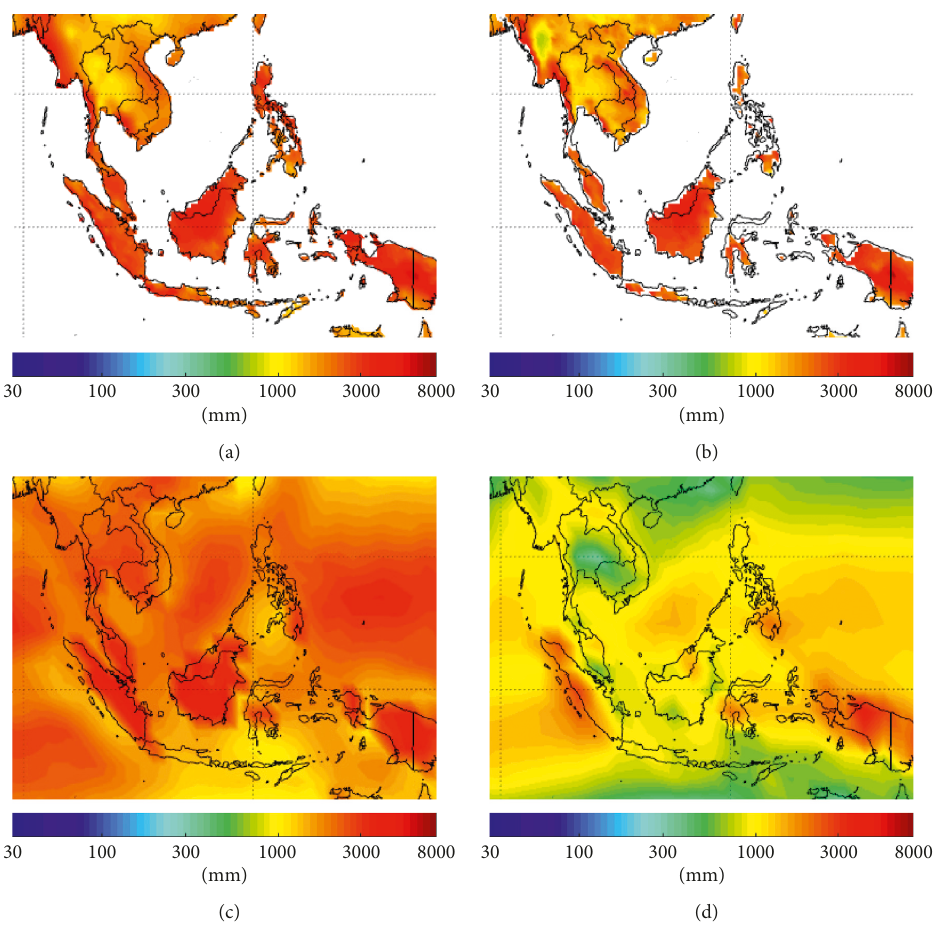
Figure 3: Comparison of the mean annual precipitation (mm) for years 1960–1999 of (a) CRU, (b) UD, (c) NCEP, and (d)